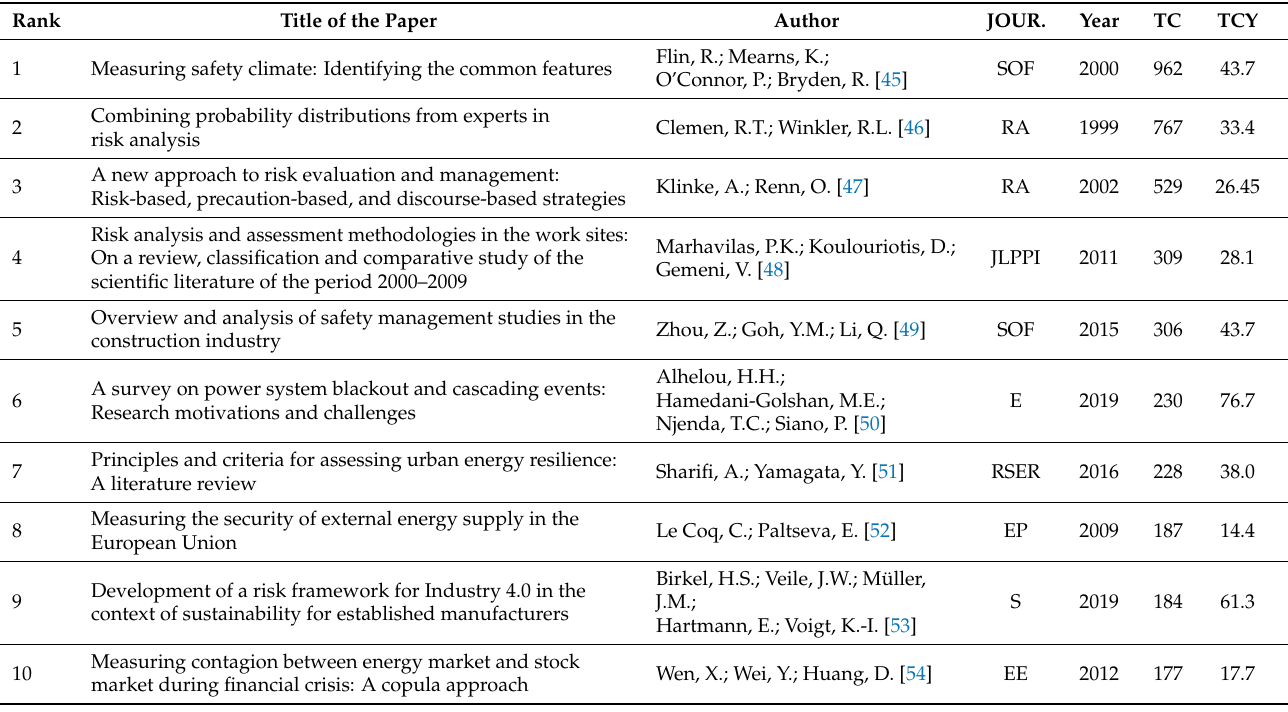
Table 2. List of the most cited